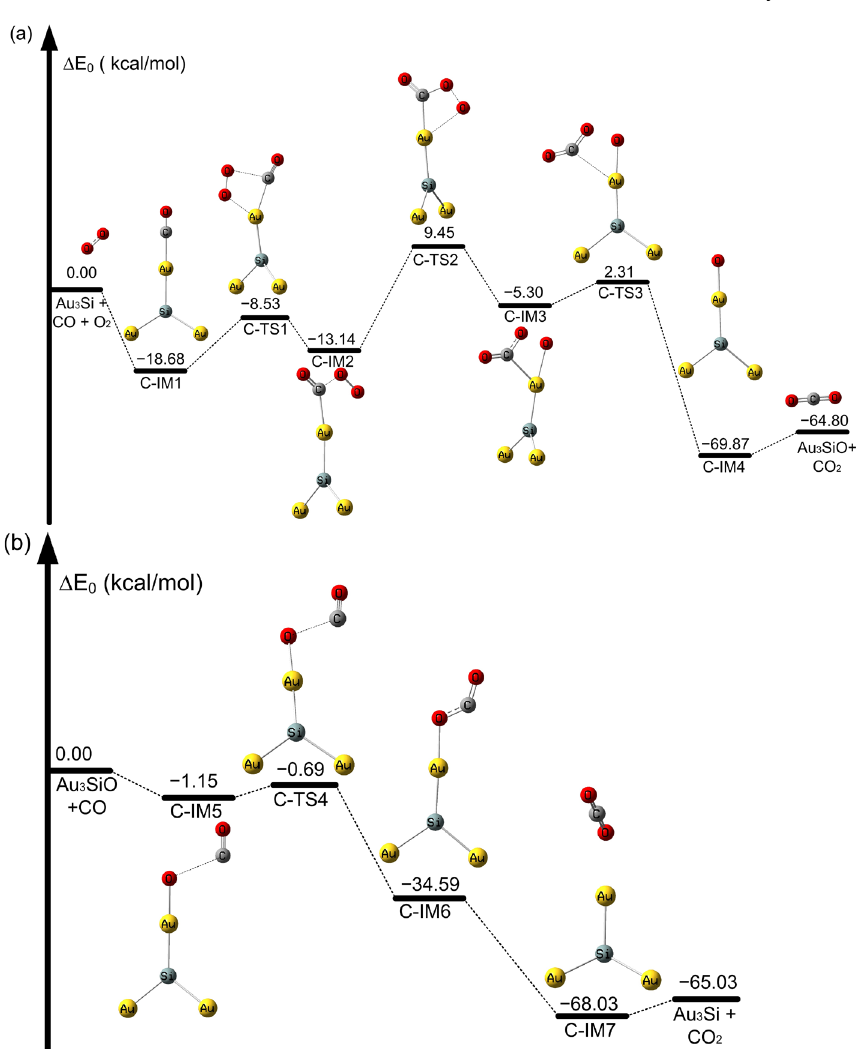
Figure 4. Potential energy profile of CO oxidation on SiAu 3 atoms at the CAM-B3LYP/aug-cc-pVDZ- PP level. ( a ) Oxidation of CO on the SiAu 3 cluster and ( b ) oxidation of CO on the OSiAu 3 cluster (in